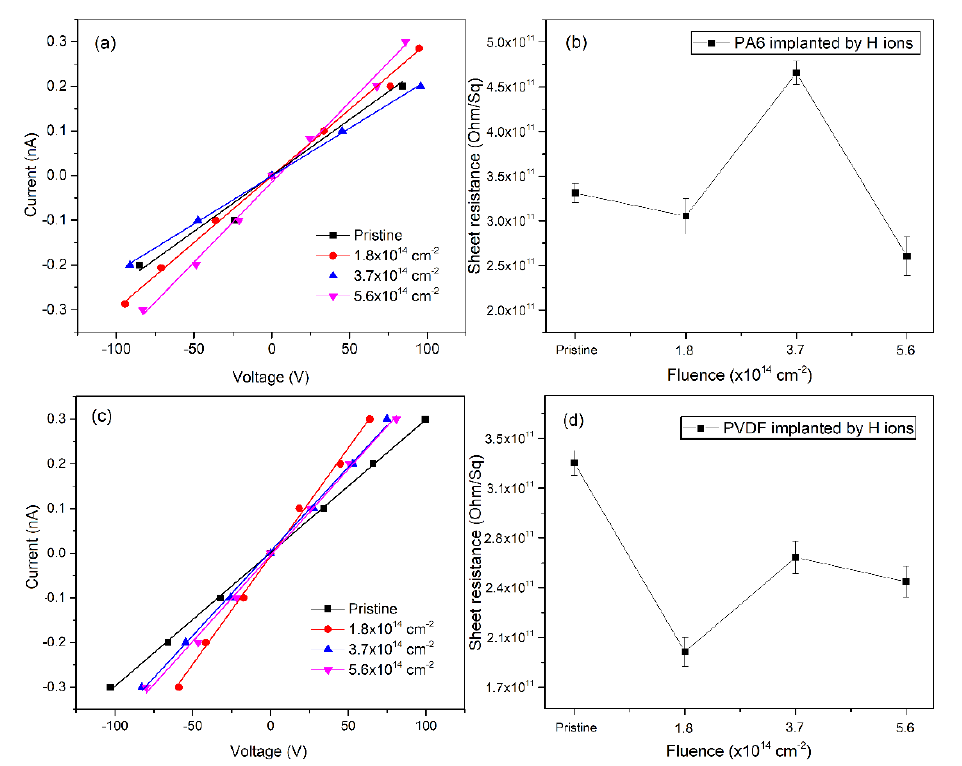
Fig. 5 . IV-characteristics of modified PA6 (a) and PVDF nanofibers (c) with sheet resistance of the H- ion irradiated PA6 (b) and PVDF (d) using the various H-ion irradiation